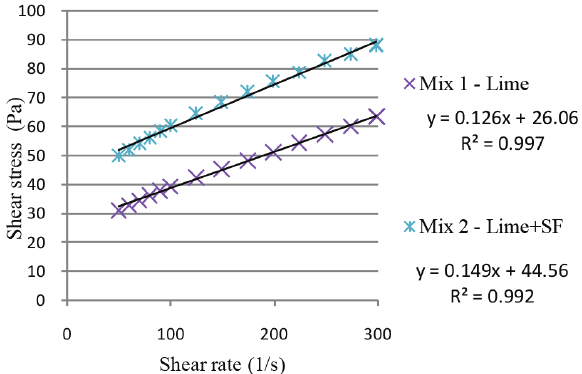
Fig. 2. Fitting the Bingham equation to the linear part of the flow curve of mix 1 and 2